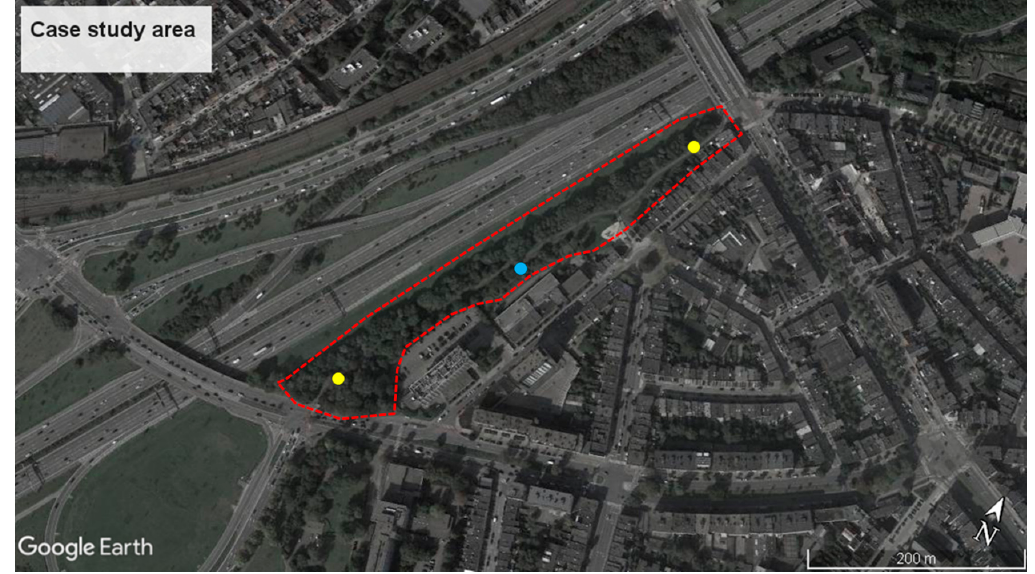
Figure 1. The investigated cycling path goes across the urban green area inside the red dashed line, bordering the ring road. The yellow dots represent the survey positions, at the end of the cycling path; the blue dot represents the microphone position.